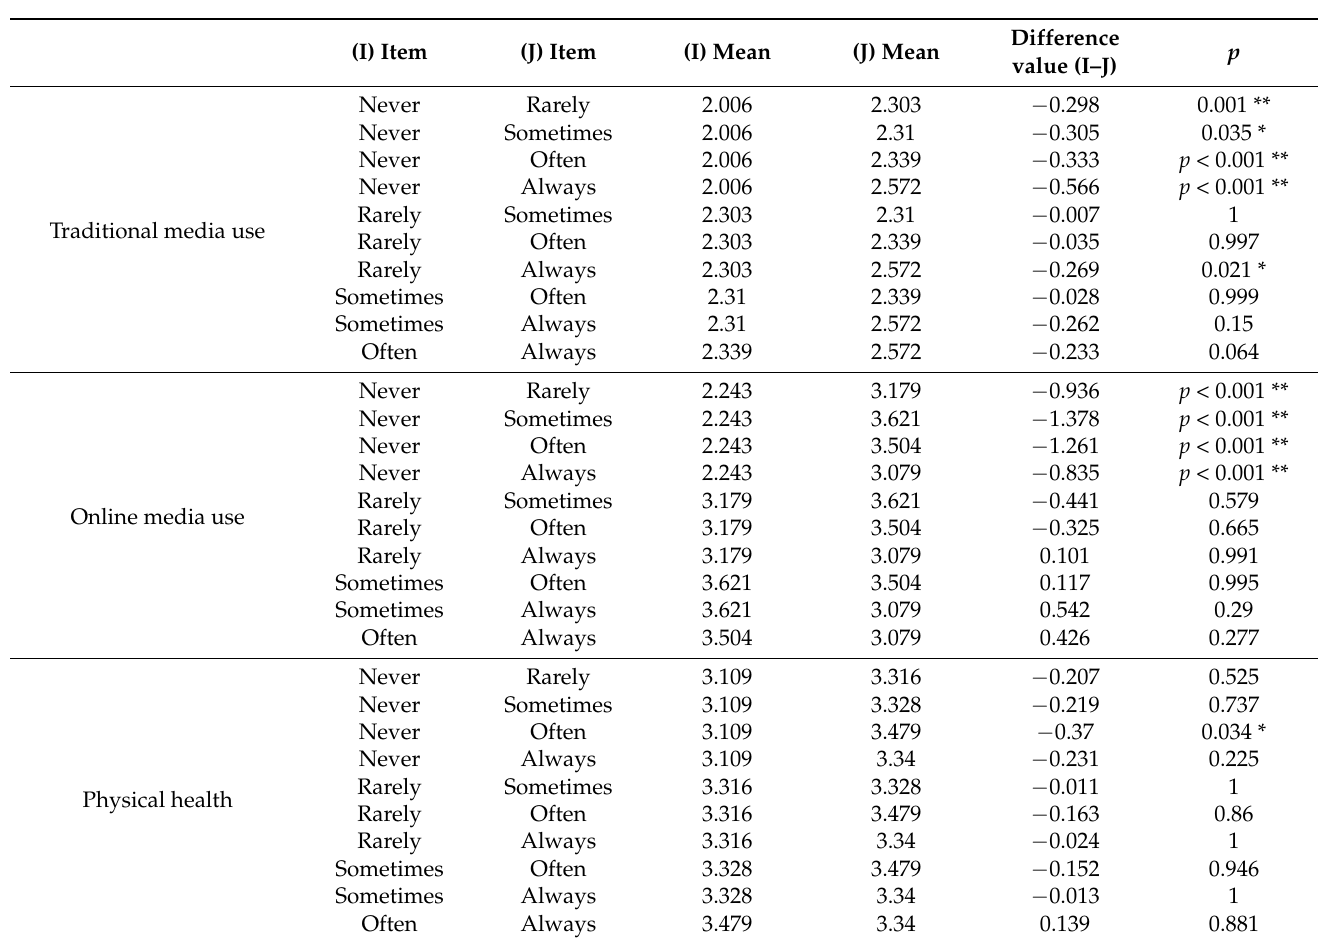
Table 4. Results of post hoc